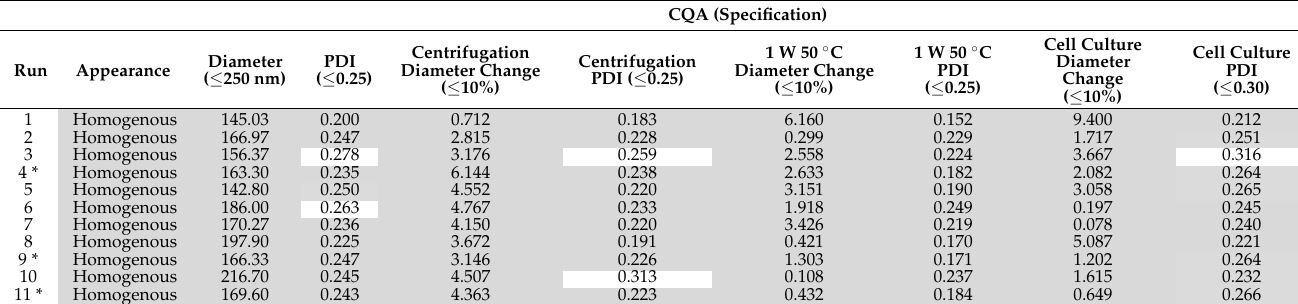
Table 2. Summary of CQA specification testing for DoE runs.